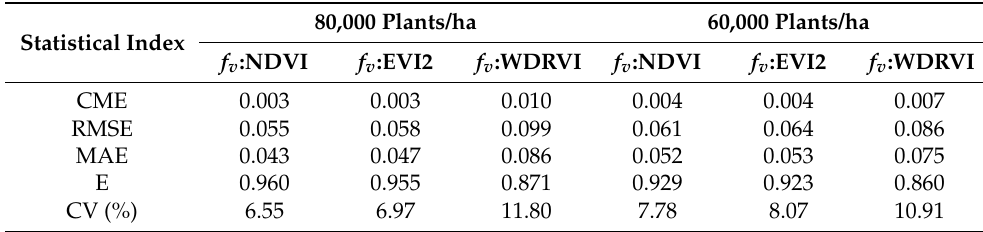
Table 6. Performance of Kc f v:VIs models.